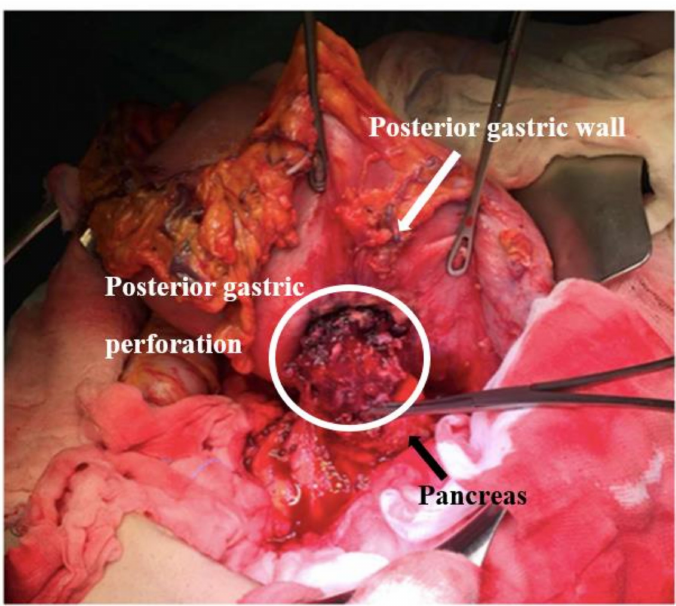
Figure 8. Intraoperative finding of perforation of the posterior gastric wall (white